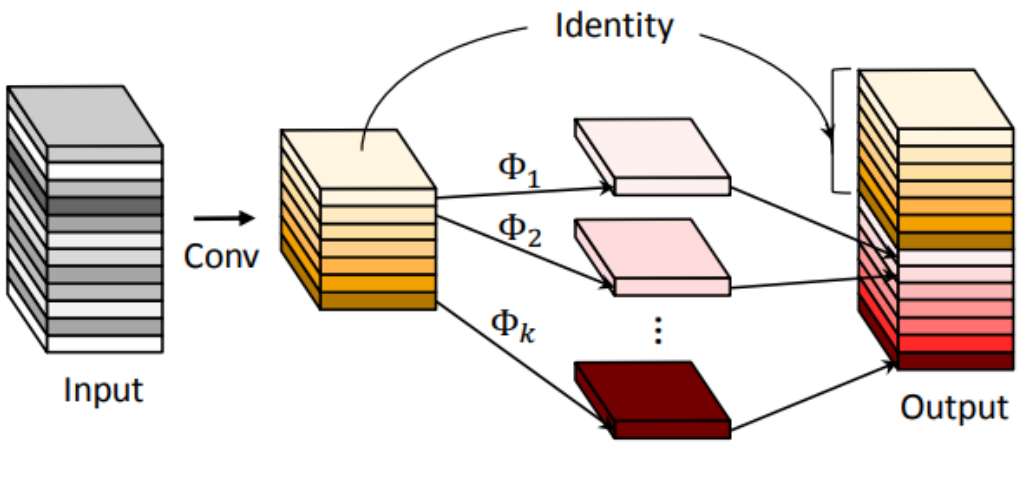
Figure 4. Ghost module